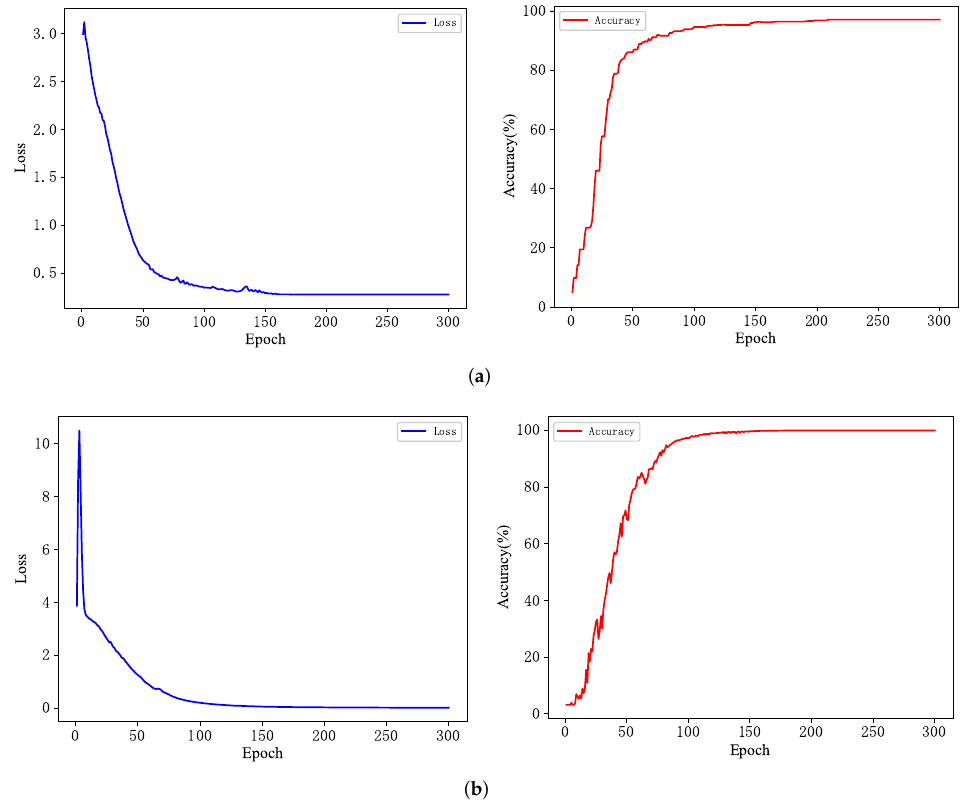
Figure 8. Visualization of the training loss and testing accuracy curve of different datasets. ( a ) SEU dataset, ( b ) CMO